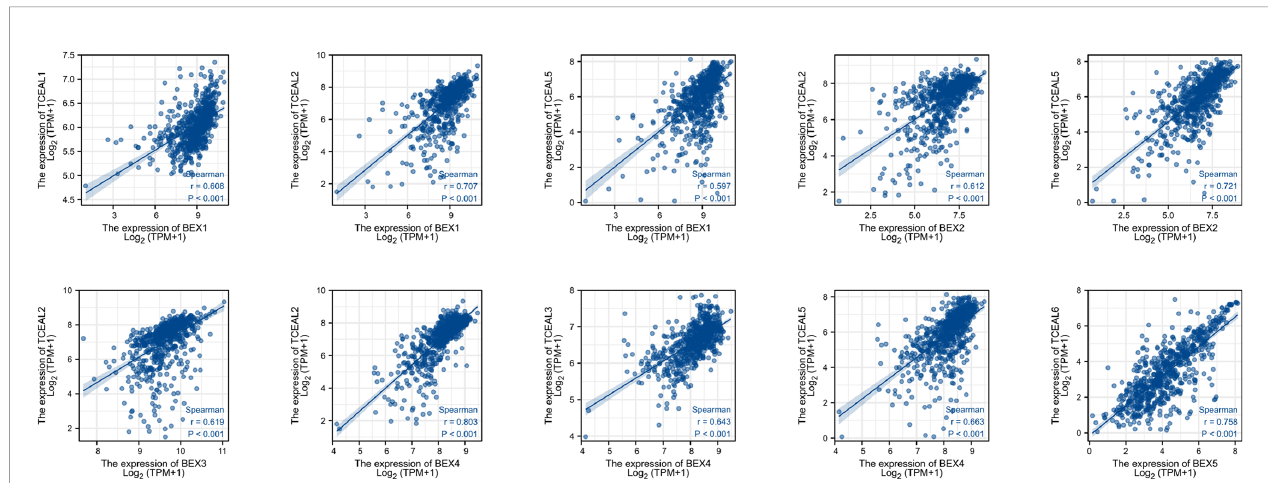
FIGURE 3 | Single-gene correlation analysis showed that BEX family was highly correlated with TCEAL family.